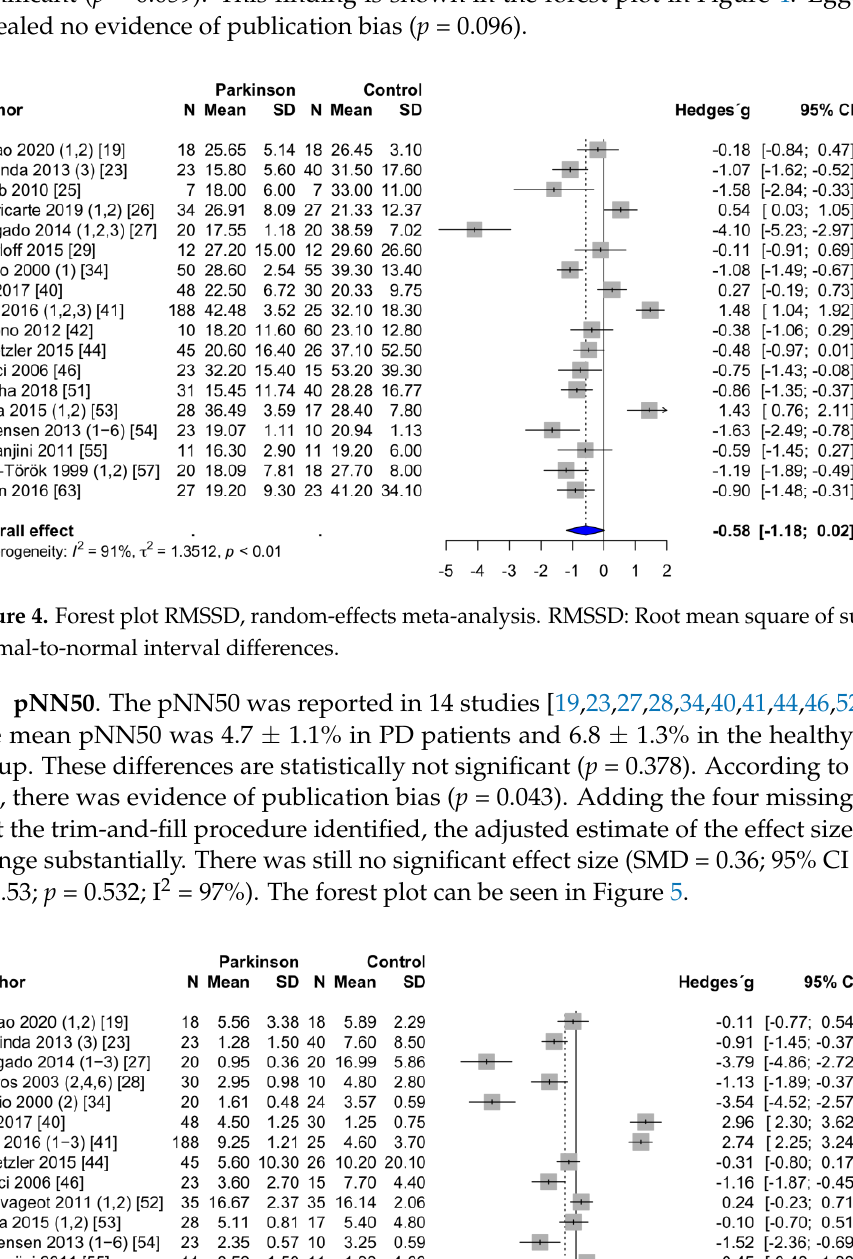
Figure 3. Forest plot HFnu, random-effects meta-analysis. HFnu: High-frequency components of the power spectral den- sity in normalized units.